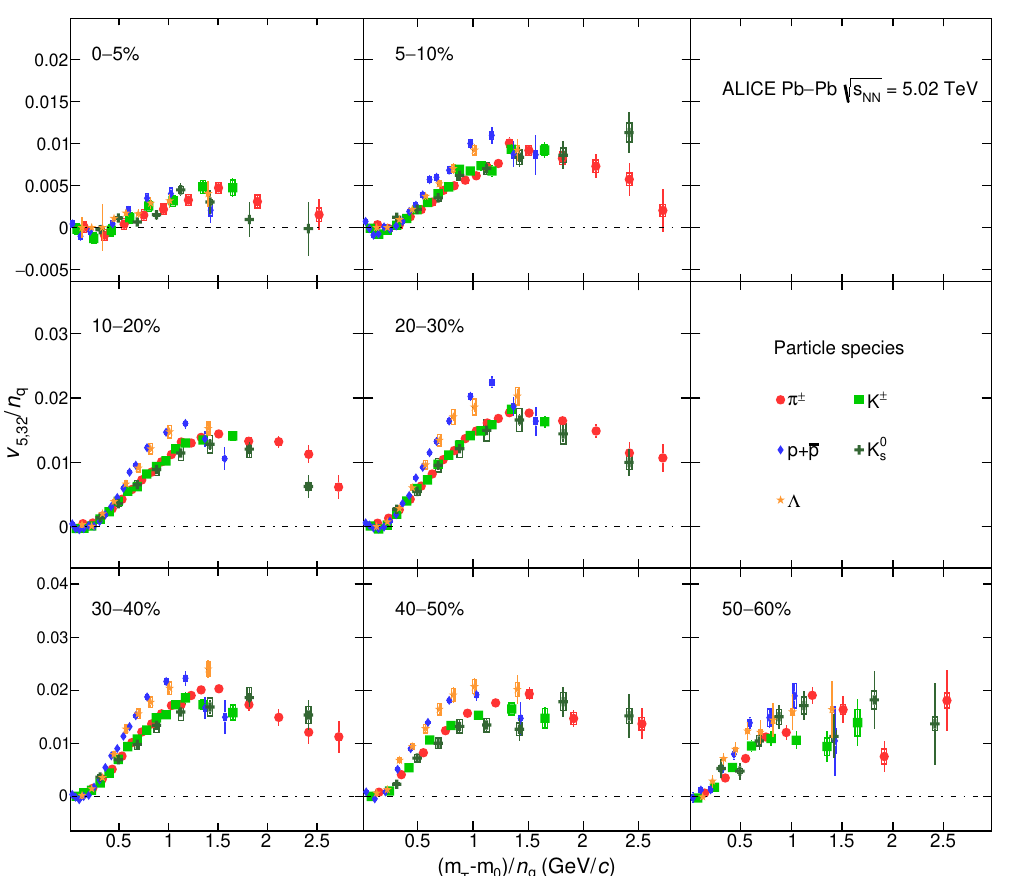
Figure 23 . The ( m T (cid:0) m 0 ) =n q -dependence of v 5 ; 32 =n q for di(cid:11)erent particle species grouped into p di(cid:11)erent centrality intervals of Pb-Pb collisions s NN = 5 : 02 TeV. Statistical and systematic un- certainties are shown as bars and boxes, respectively. It is seen that the KE T scaling holds for v 5 ; 32 at an approximate level.